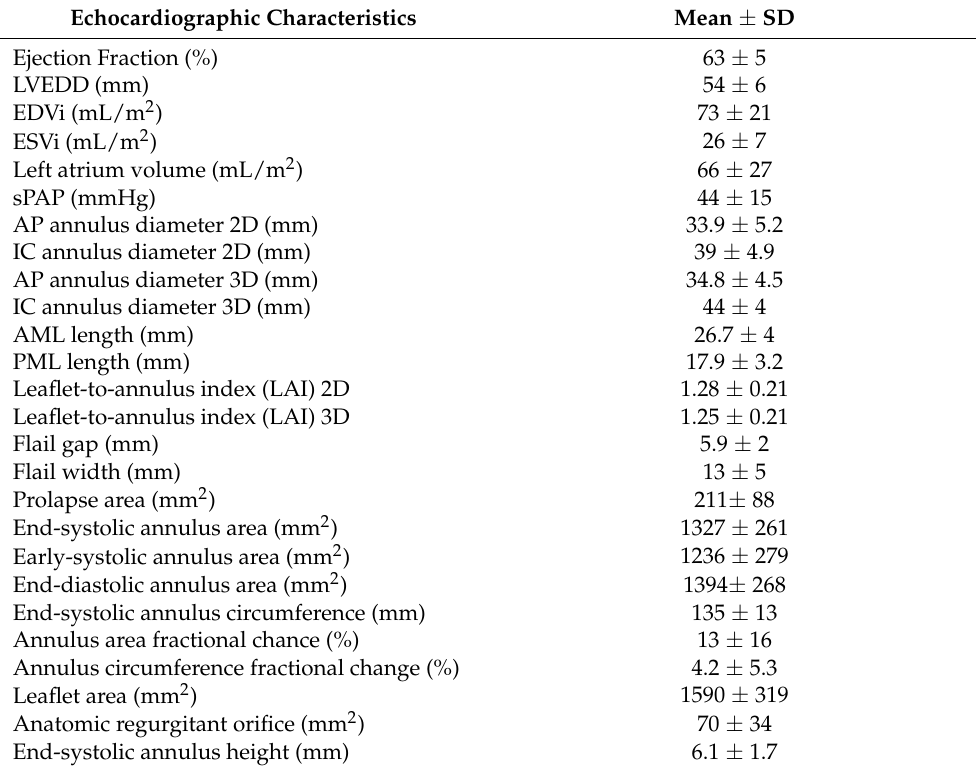
Table 2. Baseline echocardiographic